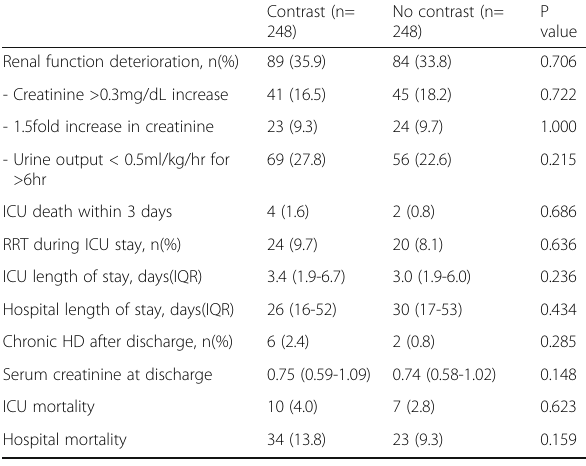
Table 1 (abstract 000210). See text for